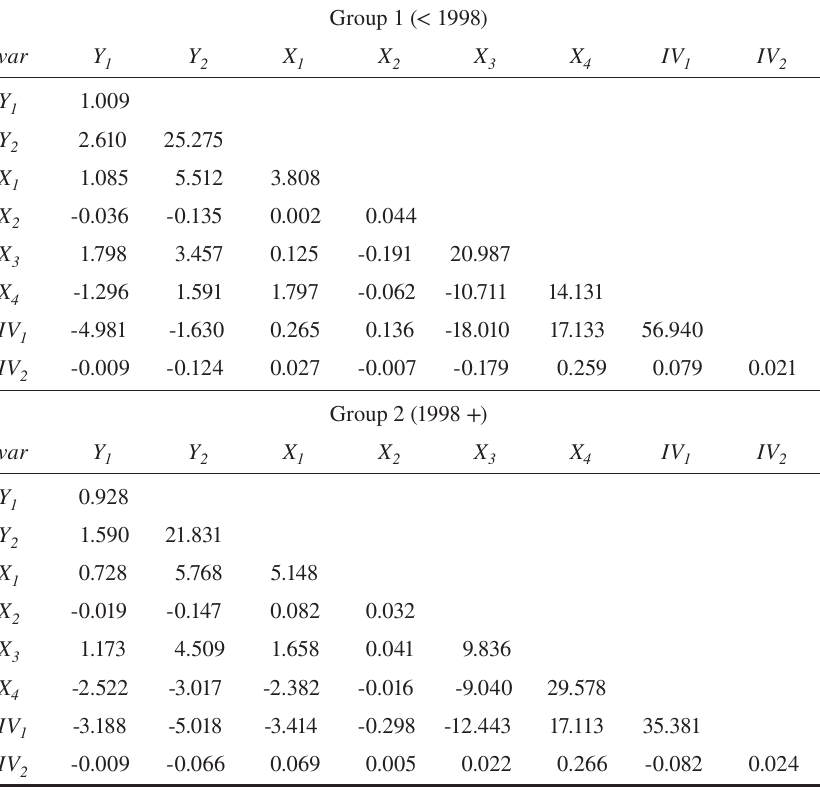
Table A10 Implied Covariance Matricies for M3 by Group Group 1 (<